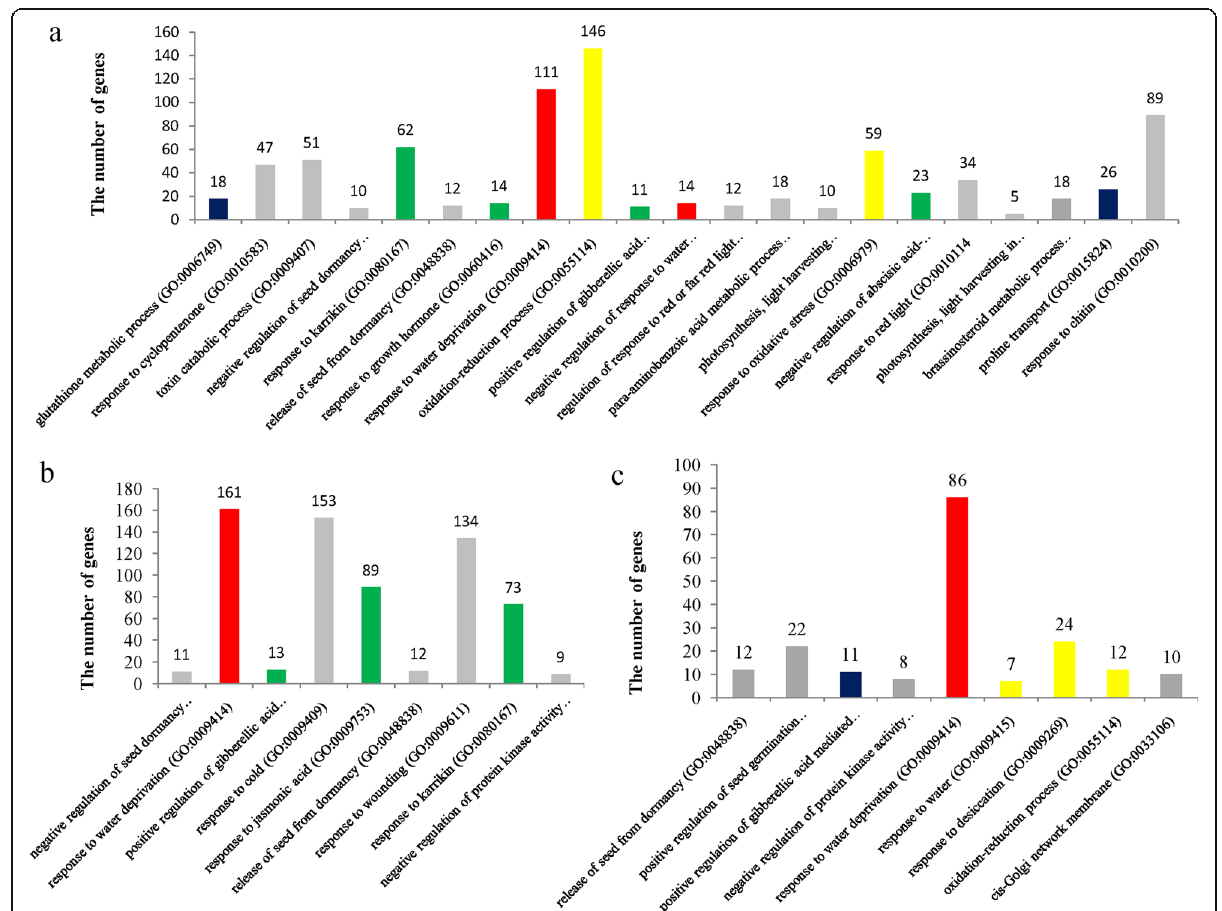
Fig. 4 GO analysis of the detected DEGs at the seedling stage. a : GO enrichment of DEGs at the sampling point SSI; b : DEGs enriched in biological processes at the sampling point SSII; c : DEGs enriched in biological processes at the sampling point